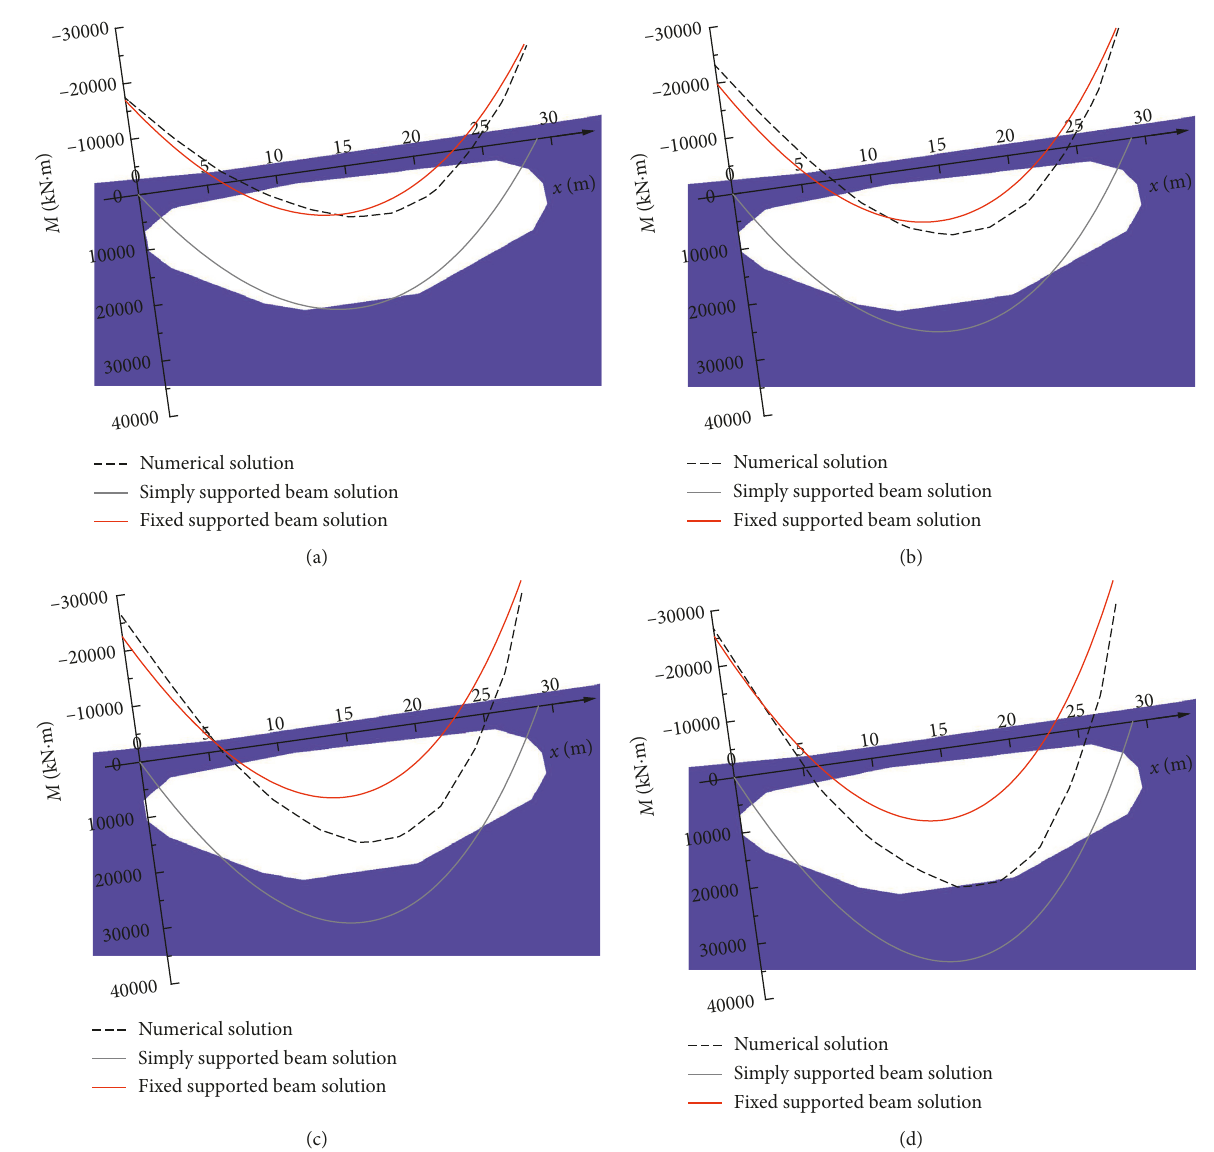
Figure 21: Bending moment of bedrock. (a) Stage 1. (b) Stage 2. (c) Stage 3. (d) Stage Table 6: Calculating schemes of the bending moment. Scheme Bending moment solution Numerical simulation